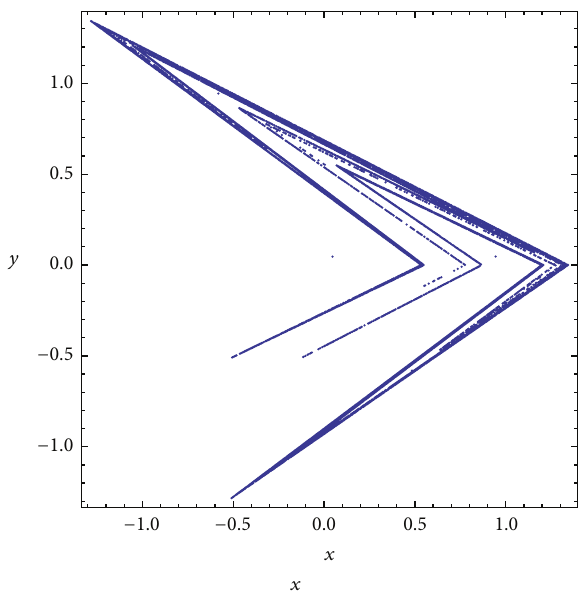
Figure 7: 𝑥 , 𝑦 plot of the Lozi